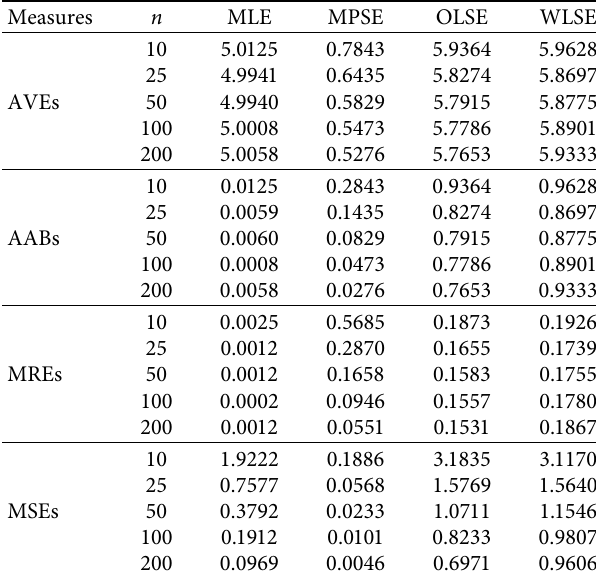
Table 8: Simulation results for β �